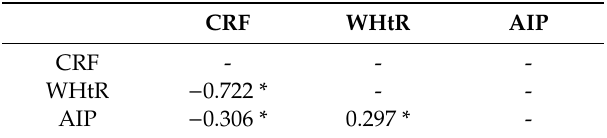
Table 2. Partial correlation coe ffi cients between the AIP, CRF, and the WHtR, Chilean national health survey 2016–2017 ( n = 4671).